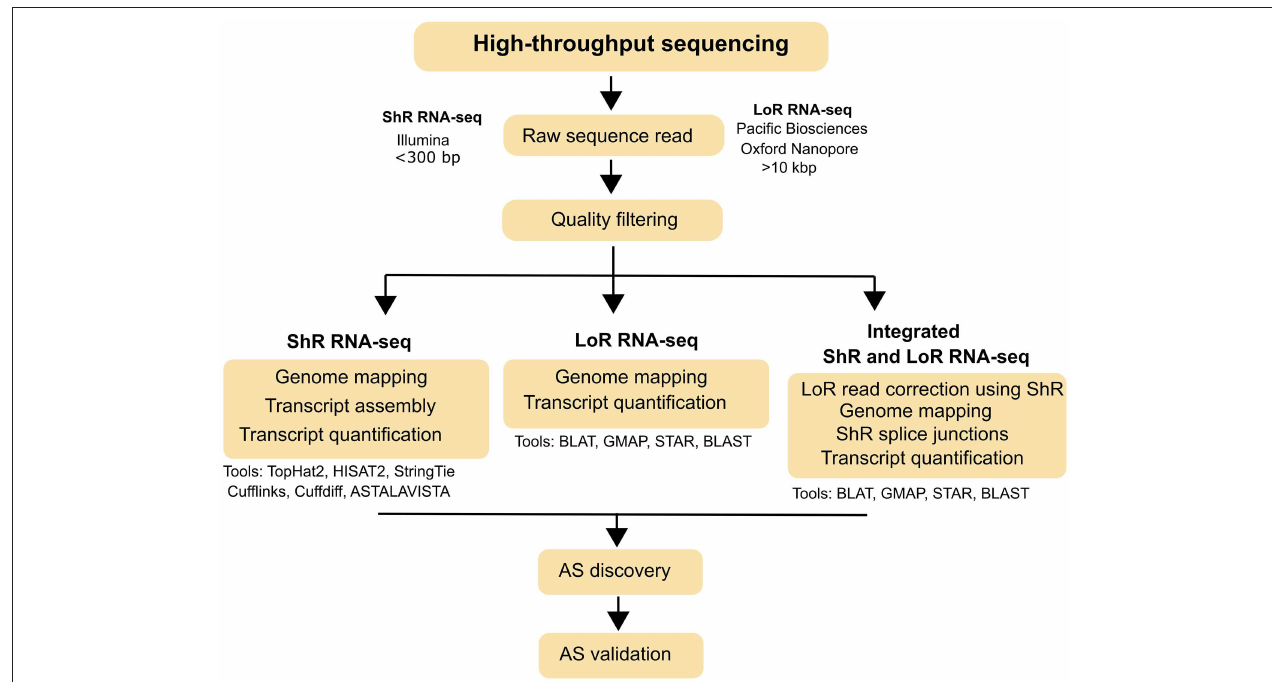
FIGURE 1 | Typical workflow for AS identification from short read (ShR) and long read (LoR) RNA-seq. AS identification strategies using ShR and LoR RNA-seq and the various bioinformatics tools that can be used for each strategy are also